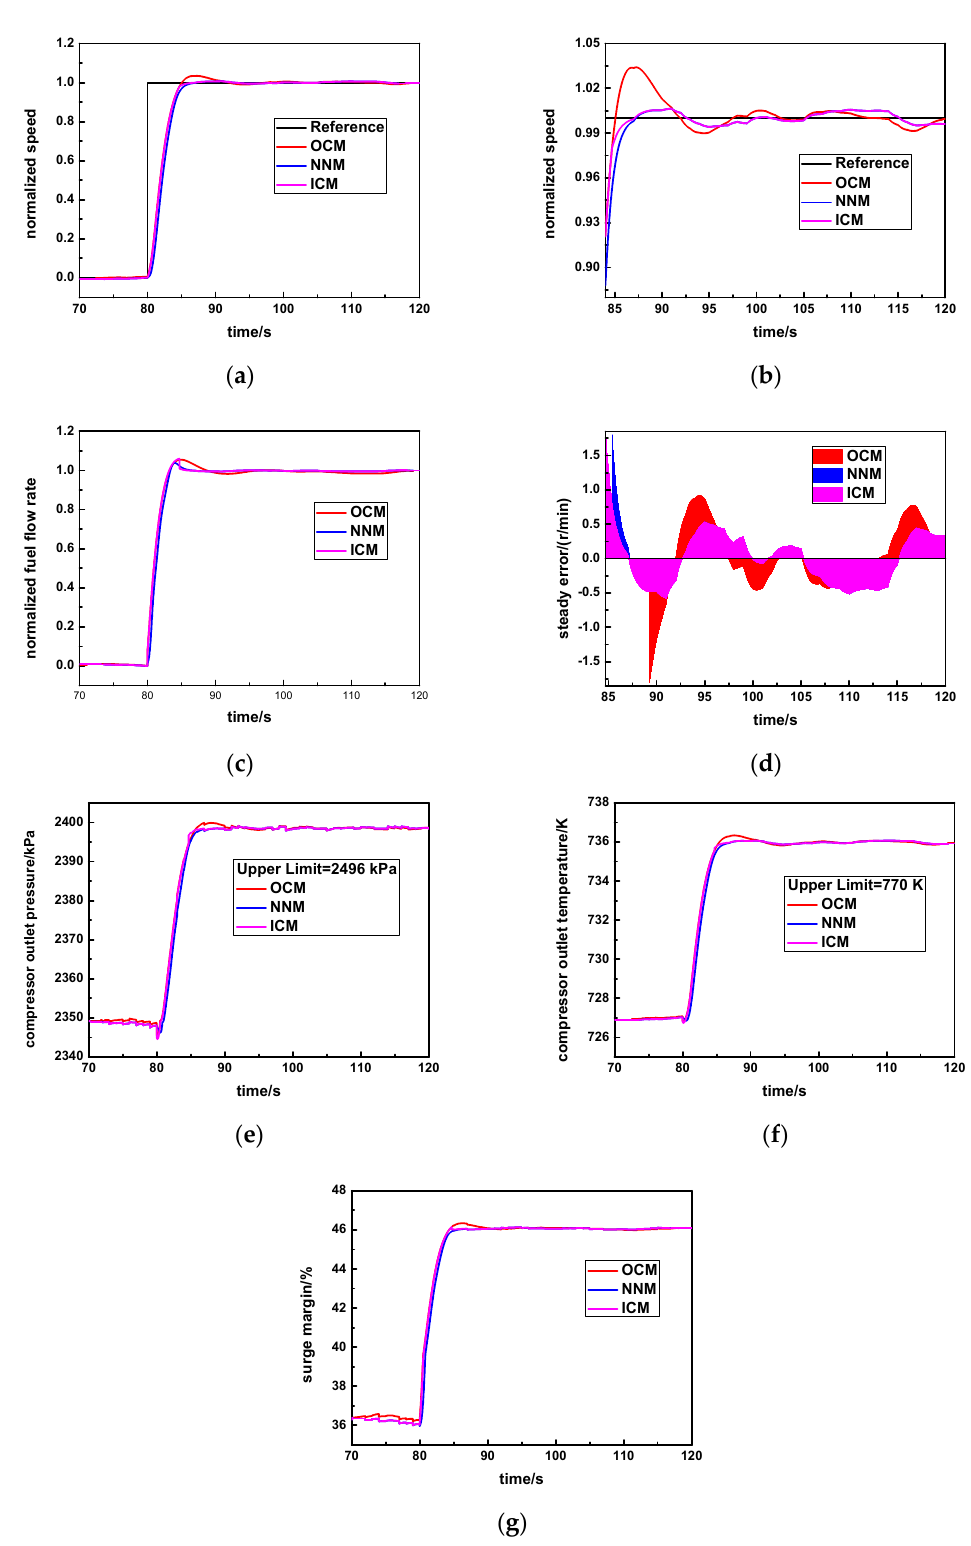
Figure 14. Related parameters distribution of second robustness test. ( a ) Speed response curve, ( b ) Locally enlarged speed curve, ( c ) Fuel flow rate curve, ( d ) Steady error of second robustness test, ( e ) Compressor outlet pressure, ( f ) Compressor outlet temperature, ( g ) Surge margin of compressor. Table 7. Tracking performance indexes of three control methods.